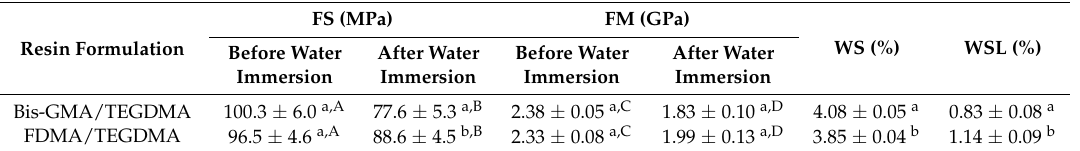
Table 2. Flexural strength (FS), flexural modulus (FM), water sorption (WS), and solubility (WSL) of cured